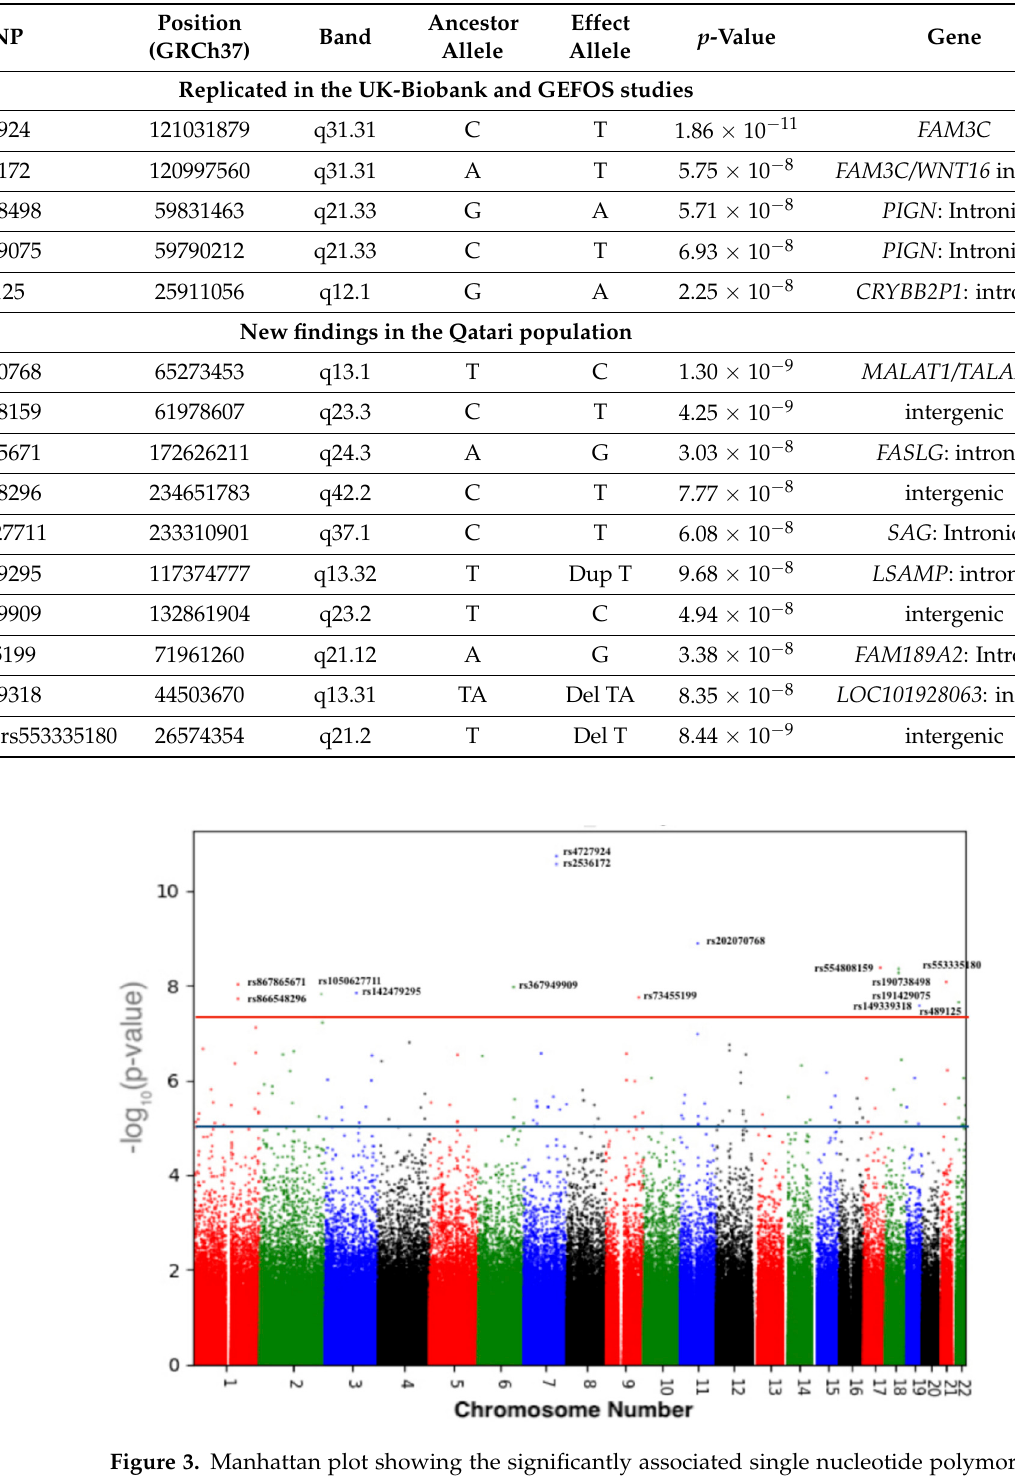
Figure 3. Manhattan plot showing the significantly associated single nucleotide polymorphisms (SNPs) with total body BMD of 3000 Qatari participants. The X-axis shows the genomic position on the 22 chromosomes. The Y-axis shows the negative log-base-10 of the p value. The red line shows the genome-wide significance level of 5.0 × 10 − 8 .